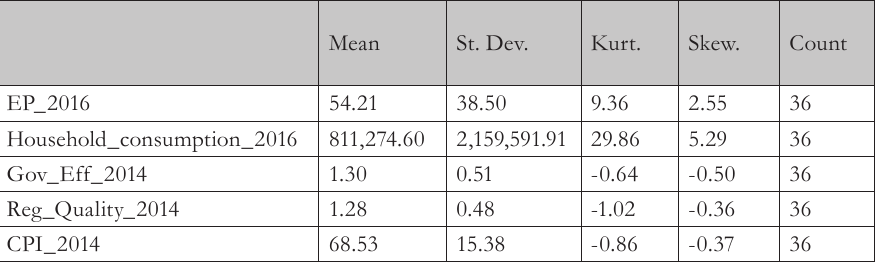
Tab. 3 – Descriptive statistics. Source: own processing by UNCTAD (2018), Kaufmann & Kraay (2018), WBG (2018), Transparency International